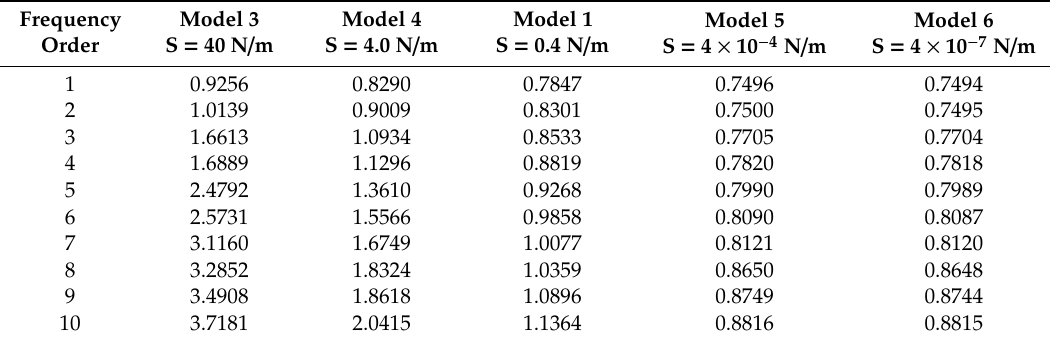
Table 6. Natural frequencies (Hz) of Mode 3, 4, 1, 5, and